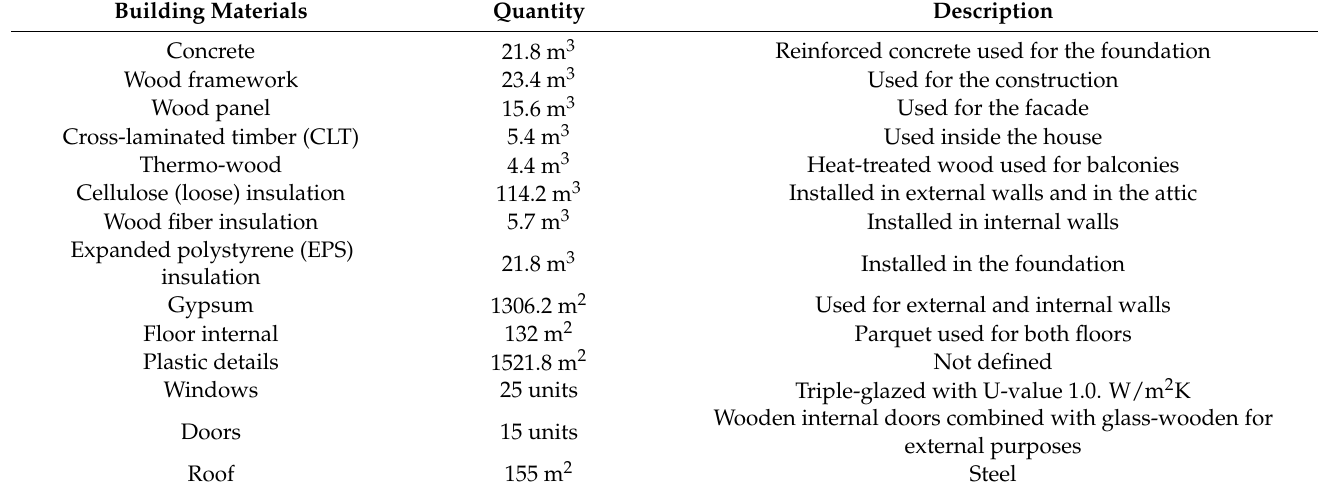
Table 3. Input data including main building materials applied in the case study, modified [44].